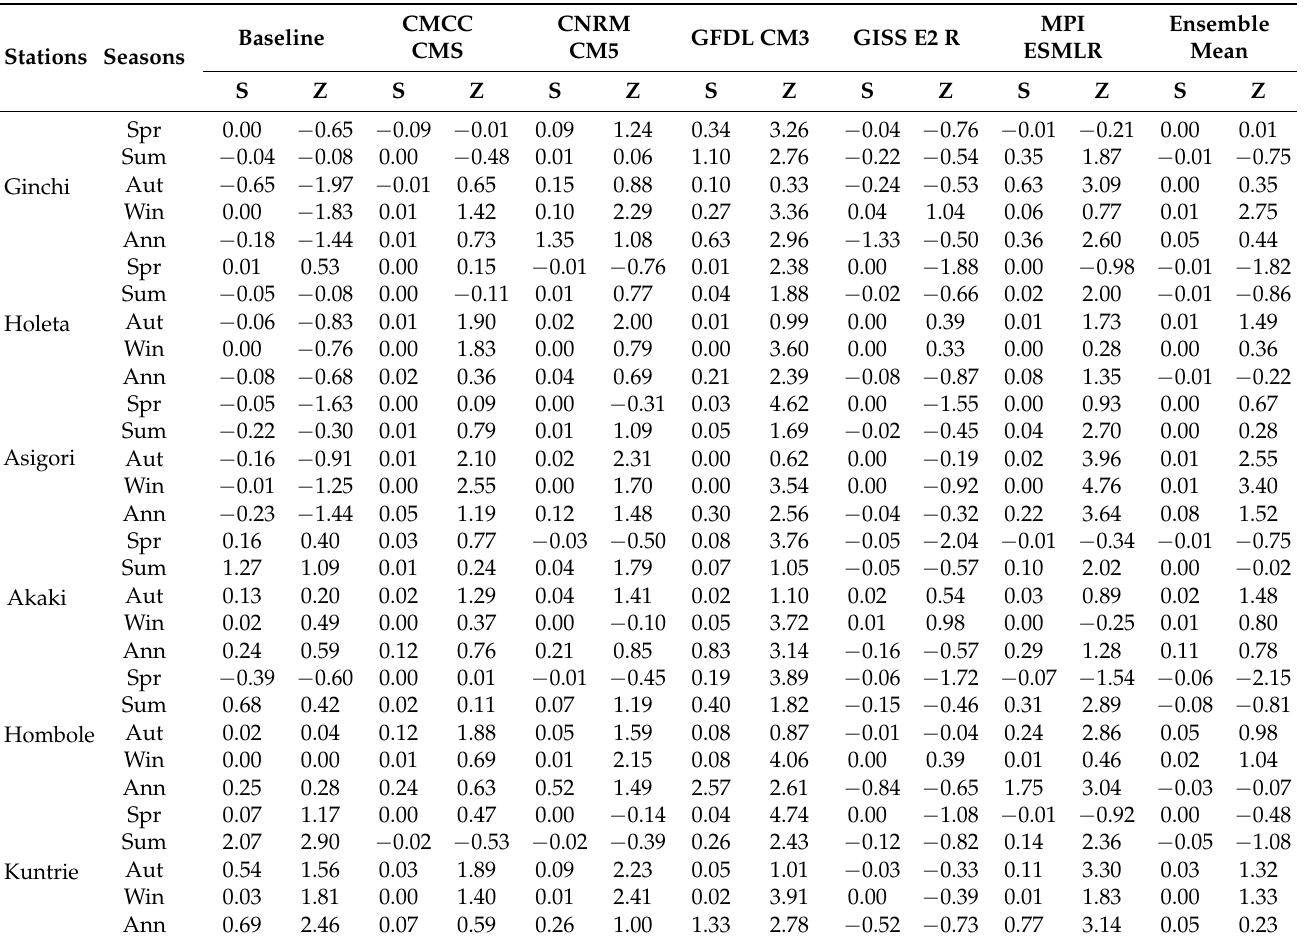
Table 11. Annual and seasonal streamflow trends for the baseline and each GCM. Minus sign ( − ) indicate negative trends. S is Sen’s slope (m 3 s − 1 ) and Z the